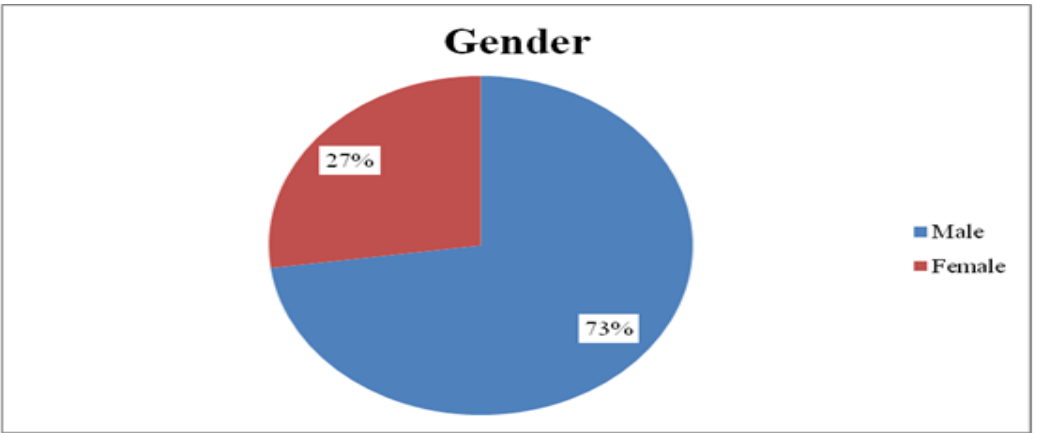
Figure 1. Distribution of study sample according to gender.